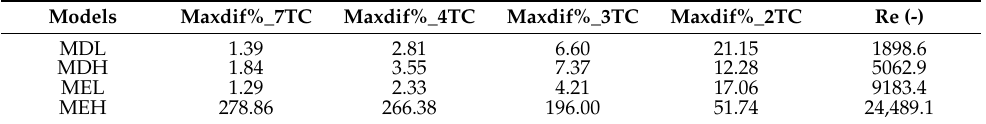
Table 5. Maximum difference (%) between the thermocline thickness determined with 12 TC com- pared to that determined with 7, 4, 3 and 2 TC, respectively, in MDL, MDH, MEL and